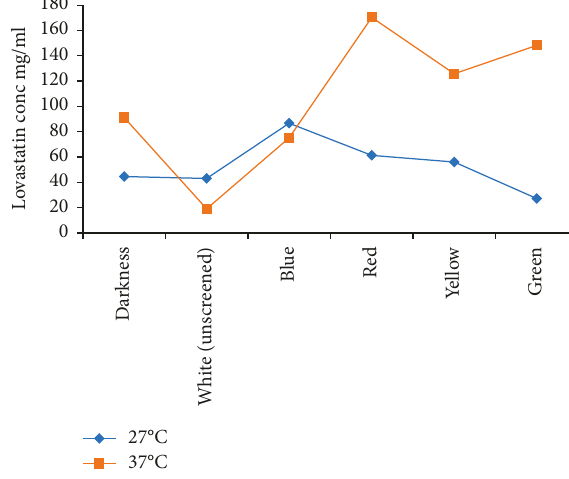
Figure 4: Intracellular lovastatin concentration (mg/ml) at 27 ° C and 37 ° C. Table 3: Intracellular lovastatin concentrations (mg/ml) at 27 ° C and 37 ° C.